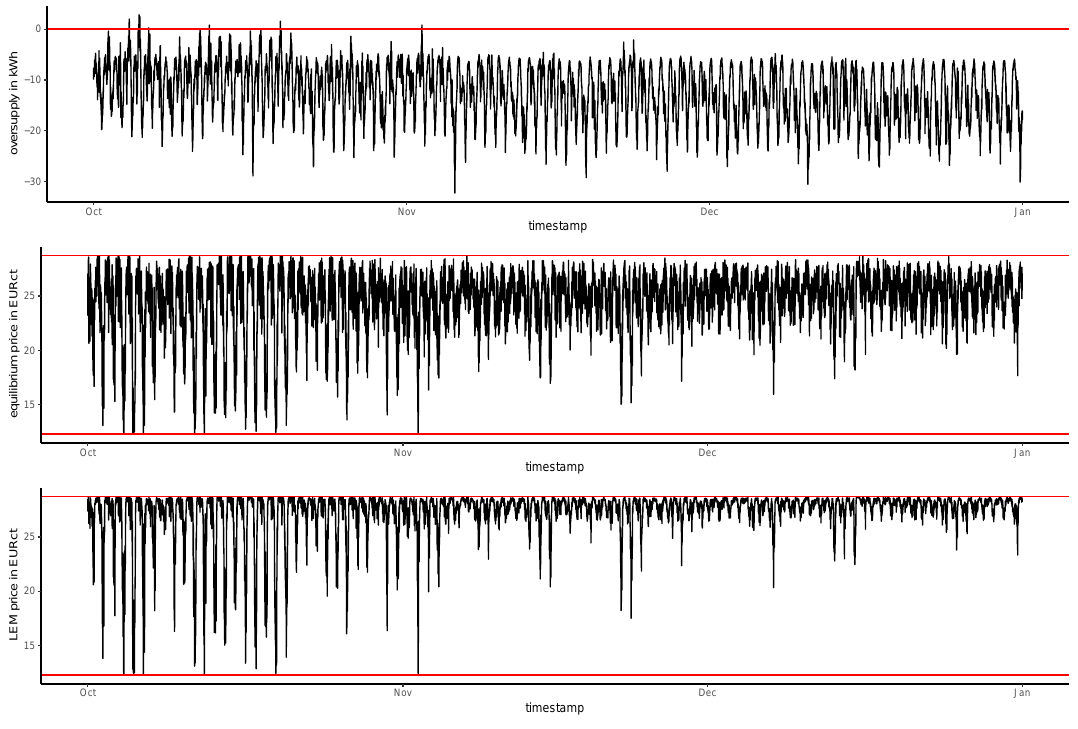
Figure 7. Market outcomes per trading period simulated with true values and a balanced supply